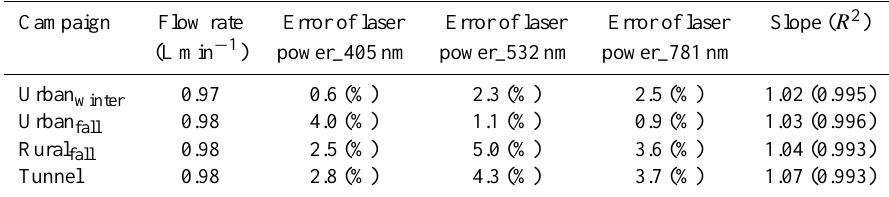
Table 1. The calibration results of PASS-3 in the campaigns. Campaign Flow rate Error of laser Error of laser Error of laser Slope ( R 2 ) (Lmin − 1 ) power_405nm power_532nm power_781nm Urban winter 0.97 0.6 (%) 2.3 (%) 1.02 (0.995) Urban fall 0.98 4.0 (%) Rural fall 0.98